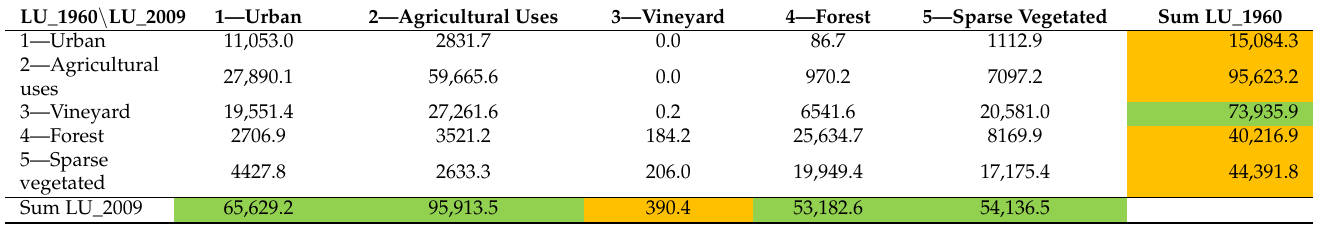
Table 8. Contingency table of land cover change for the period 1960–2009. Results represent the areas under change and are expressed in ha. Cells in orange report a loss in ha, while green ones report a net gain in